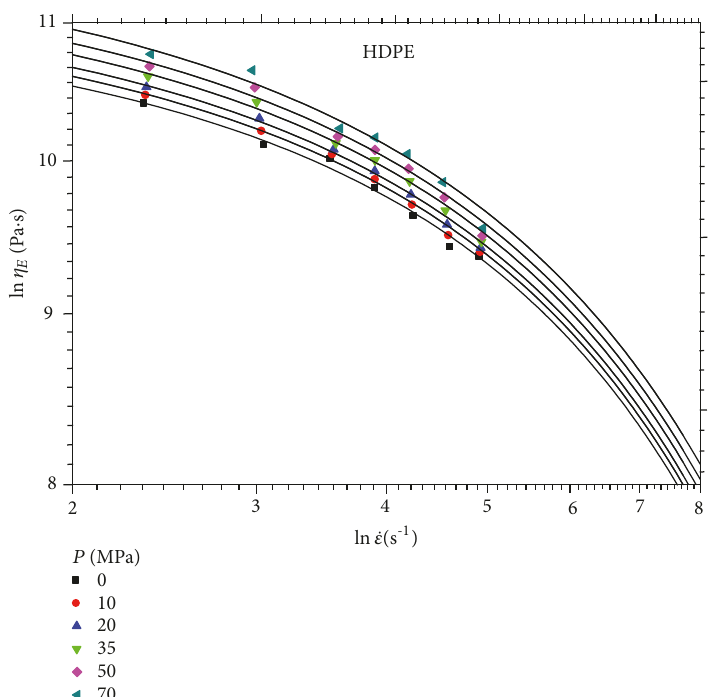
Figure 2: Logarithm of viscosity versus logarithm of elongational rate of HDPE at 210 ∘ C and various pressures. Solid lines represent data fitting through each data set [4] by (5).